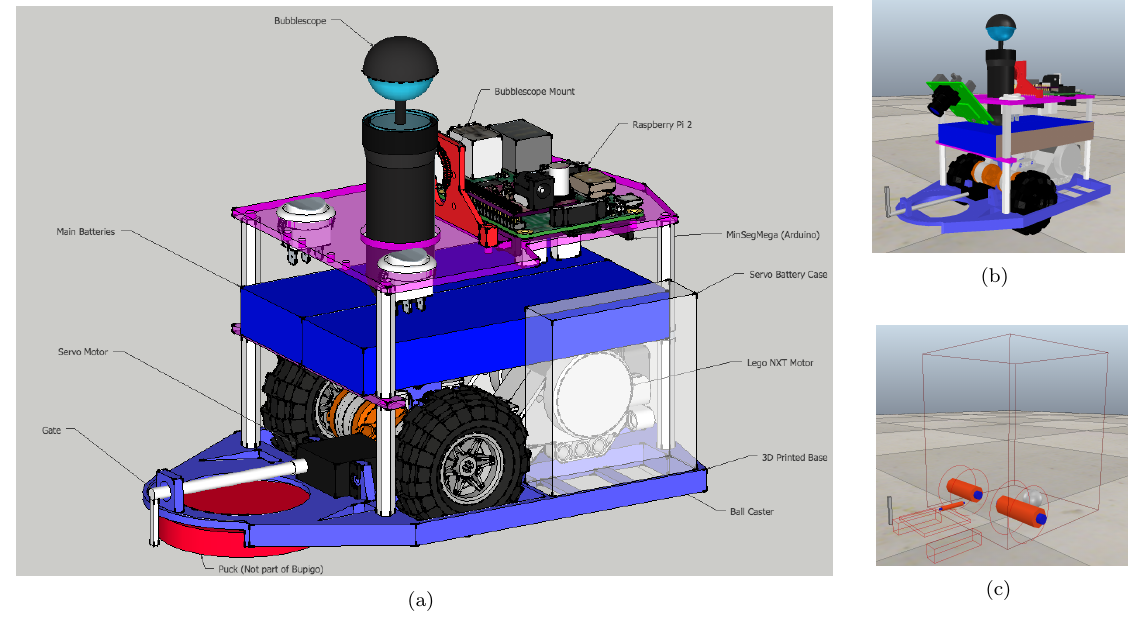
Figure 1: (a) View of the 3D model of the BuPiGo in Sketchup. Note that the 3D model does not include the Pixy camera or the Raspberry Pi camera that mounts to the Bubblescope. Also, the transparency and colours of some components are chosen for visual distinction and are not reflected in the physical robot. (b) Static model in V-REP. (c) Dynamic model in V-REP.